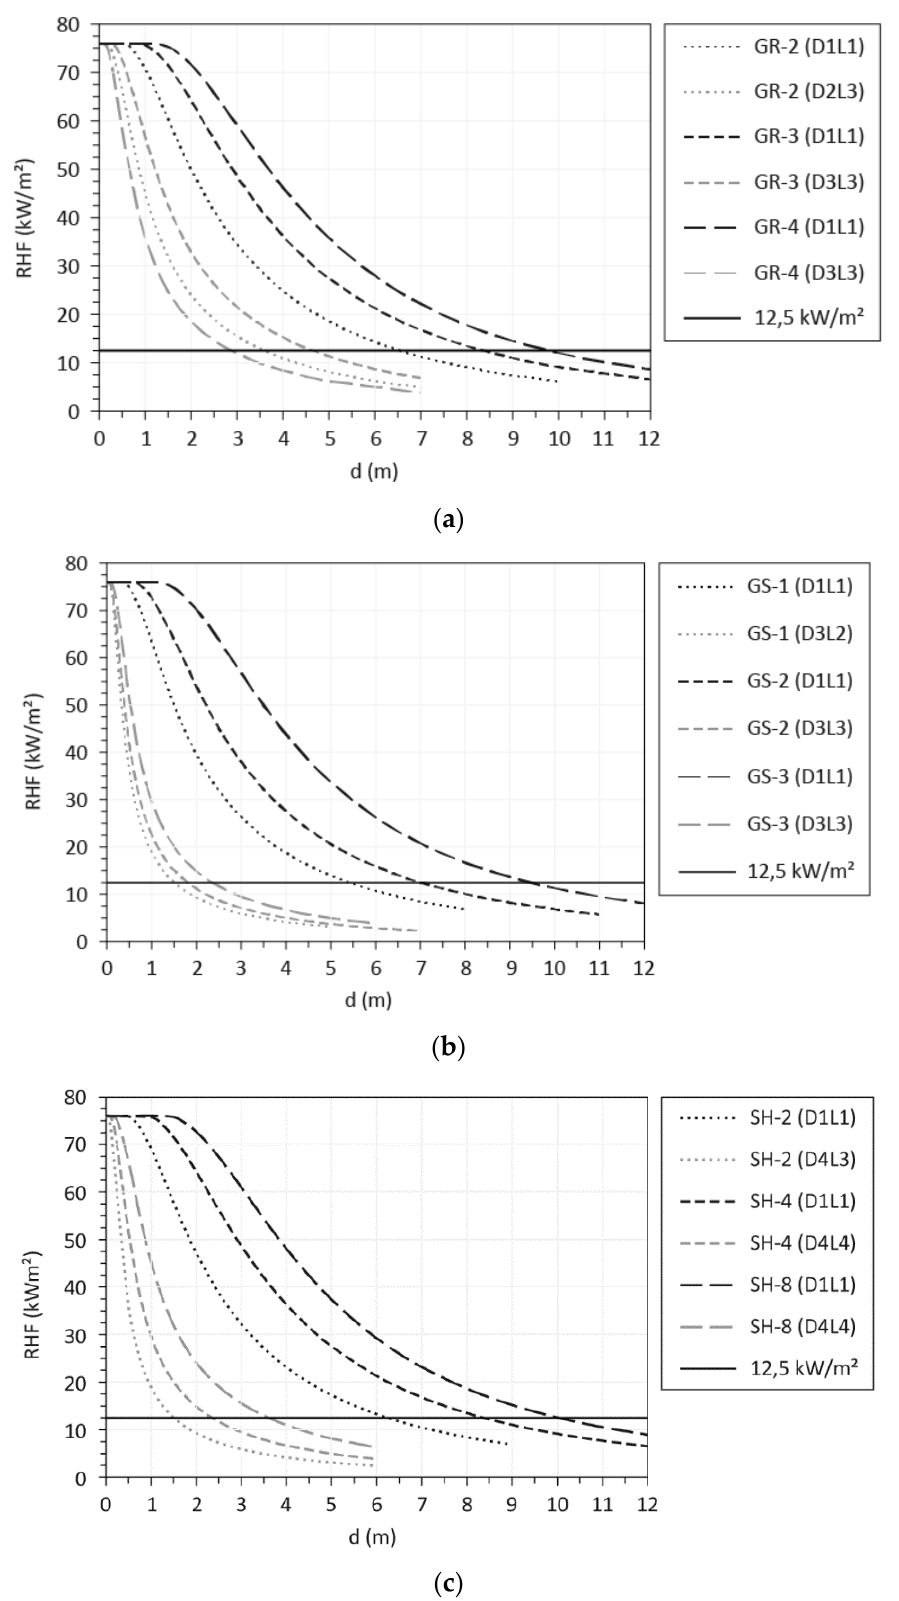
Figure 5. Radiation heat flux as a function of distance to the façade ( d ) for different fuel categories: ( a ) for Grasses, ( b ) for Grass-Shrubs, ( c ) for Shrubs.